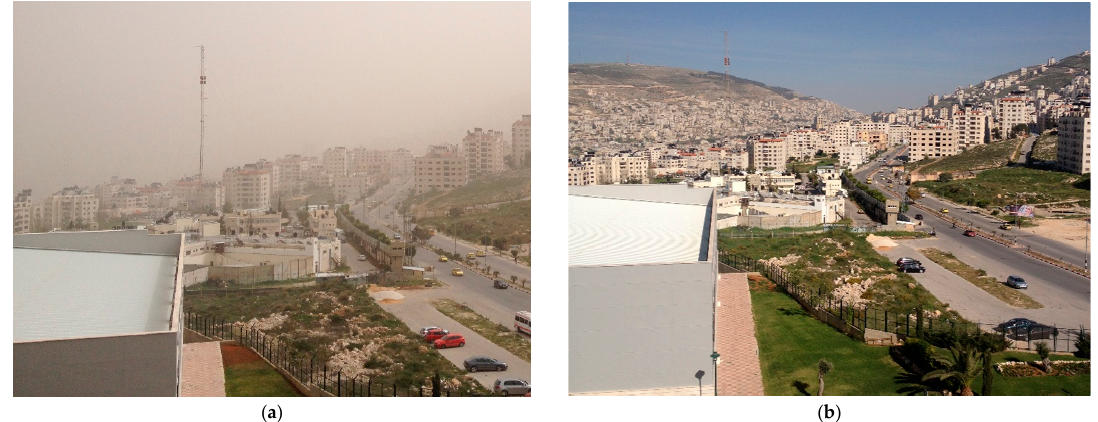
Figure 2. The visibility in the city of Nablus: ( a ) during a dust storm in March 2014; ( b ) during a clear day in April 2014. The pictures were taken from a location southwest of the city (Figure 1b) facing northeast (Mount Ebal).